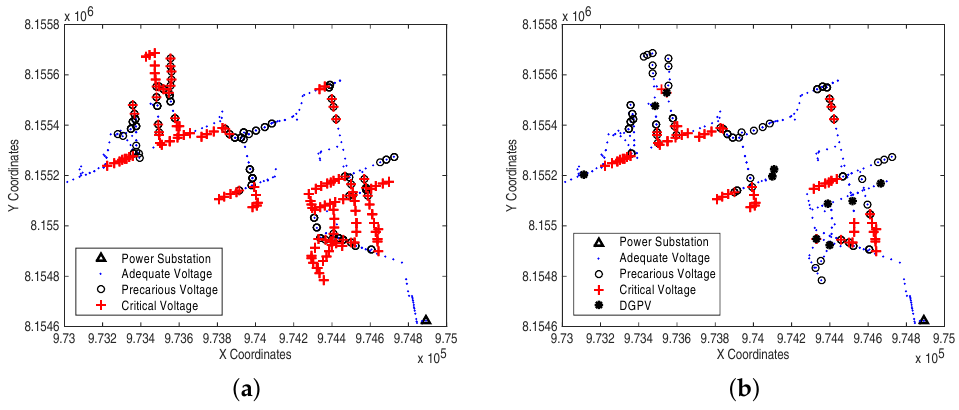
Figure 29. Result of the optimization of the variables pos and pot with bars constraint: ( a ) voltage rating before the allocations and ( b ) voltage rating after the allocations.